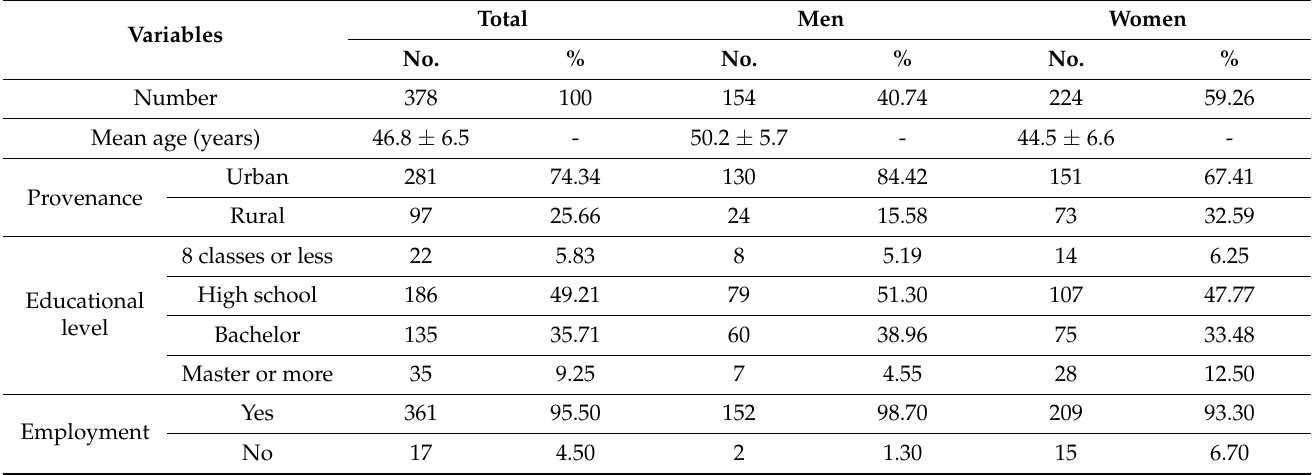
Table 1. Demographic characteristics of the